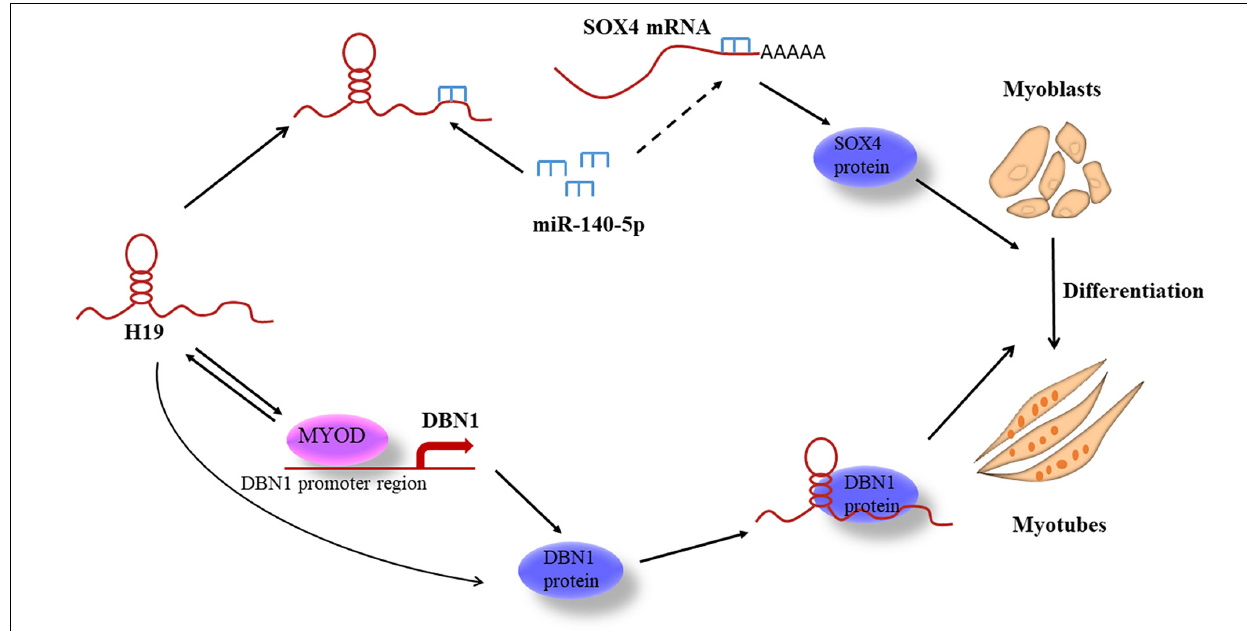
FIGURE 8 | Model for H19-regulating PSC